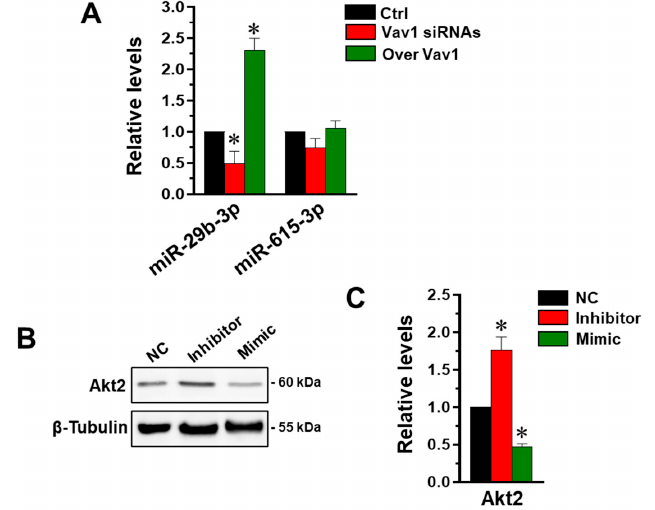
Figure 2. Correlation between Vav1, miR-29b and Akt2 in MDA-MB-231 cells. ( A ) qRT-PCR analysis of miR-29b-3p and miR-615-3p in MDA-MB-231 cells in which Vav1 was down-modulated or over- expressed. The values were determined using the 2 - ΔΔ CT method and the asterisks indicate statisti- cally significant differences compared to respective controls (Ctrl) taken as 1. ( B ) Representative immunoblot analysis of Akt2 in lysates from MDA-MB-231 cells transfected with miR-29b-3p inhib- itor or mimic. In ( C ), amounts of Akt2 as deduced from the chemiluminescence signals normalized with β -Tubulin. The asterisks indicate significant differences compared to transfection with scram- ble oligonucleotides (Negative control, NC), taken as 1. All the data represent the mean of three separate experiments ± SD. * p < 0.05.